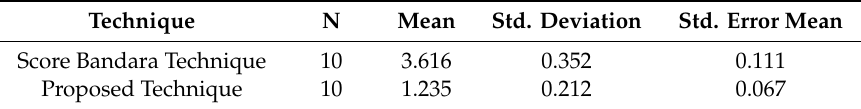
Table 8. Test statistics of t -test (Group Statistics).